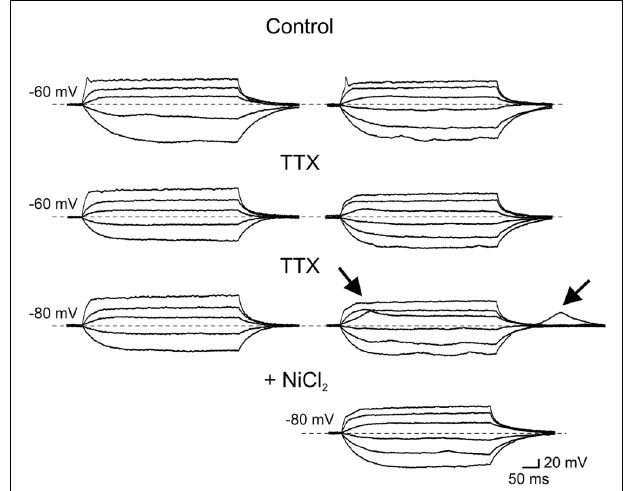
FIGURE 6 | Different patterns of coherent activities in neonatal GCs. (A) neuron (at P1) exhibiting sporadic depolarizing synaptic potentials that in few cases reached the threshold for action potential generation. (B) GDPs occurring in clusters of 2–3. (C) GDPs occurring at more regular intervals. Single action potentials or GDPs marked with * are shown on the right on an expanded time